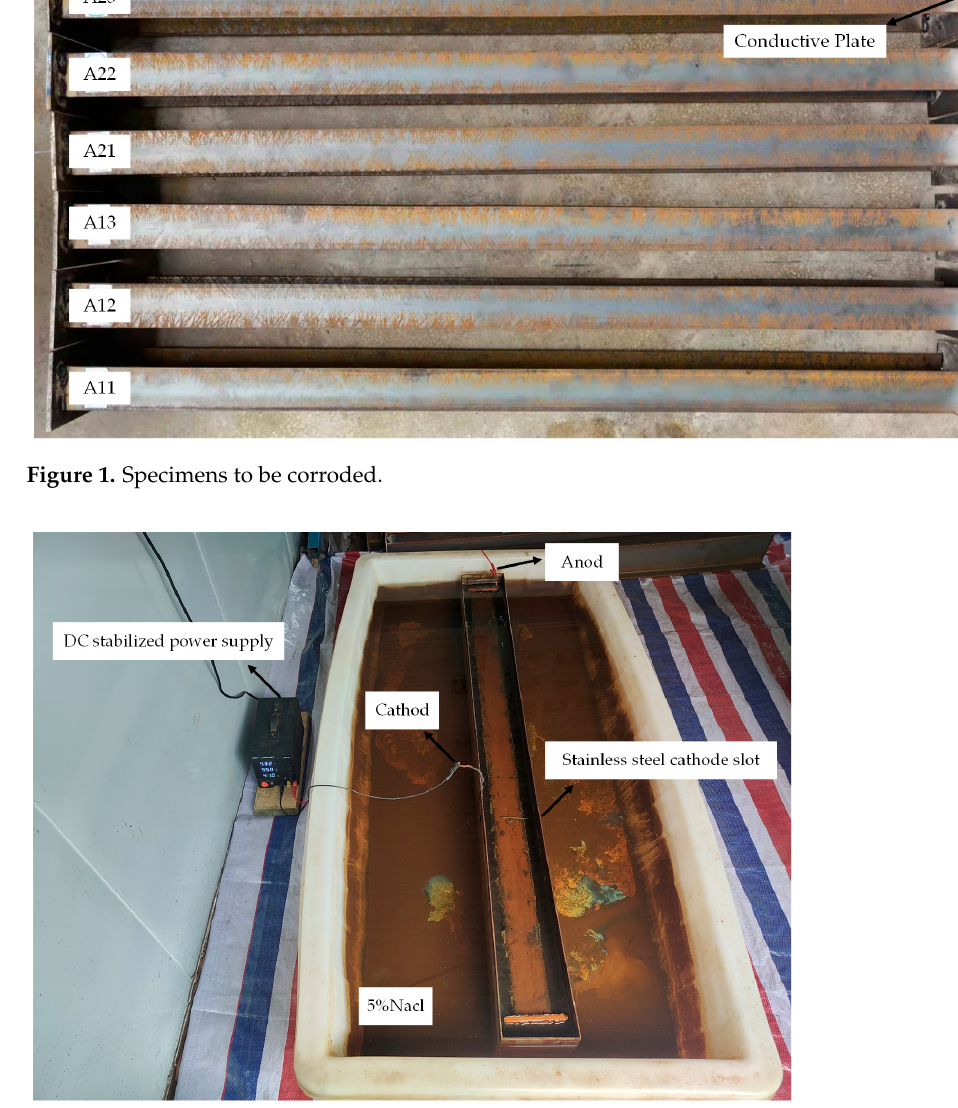
Figure 2. Electrochemical corrosion test. Upon reaching the designed corrosion rate for electrifying corrosion, the steel beam specimens were removed, were soaked in 10% dilute hydrochloric acid, and were cleaned with a steel wire brush in order to remove rust. Subsequently, the specimens were neutral- ized with limewater and aired. After the conducting plates were removed, the treated steel beam specimens were weighed, and these masses were compared with the initial masses of the specimens. Finally, the actual corrosion rates of the specimens were calculated, and the results are listed in Table